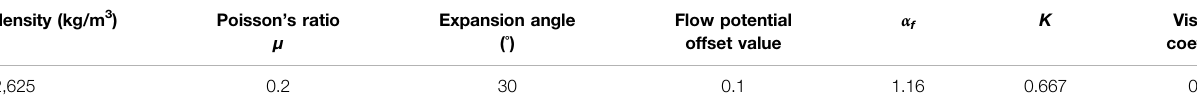
TABLE 2 | Material parameters of the ABAQUS